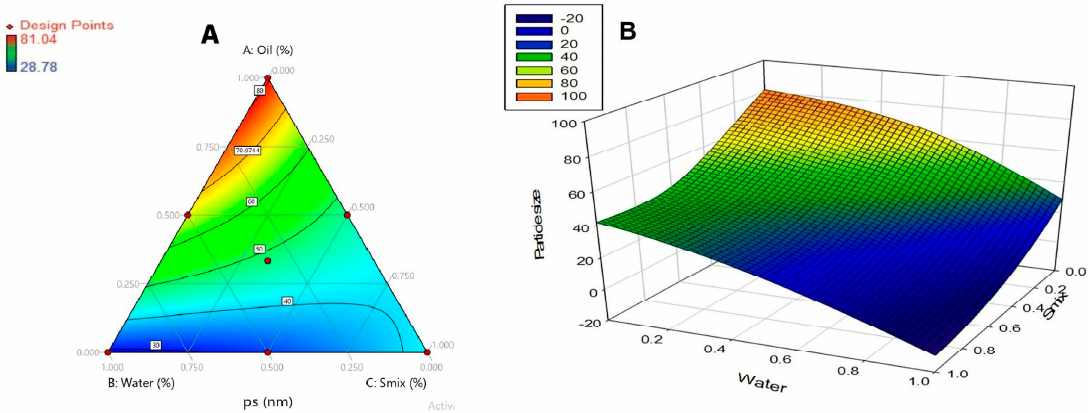
Figure 2. Contour plot ( A ) over the simplex space and response surface graph ( B ) representing nanoemulsion particle size (nm).